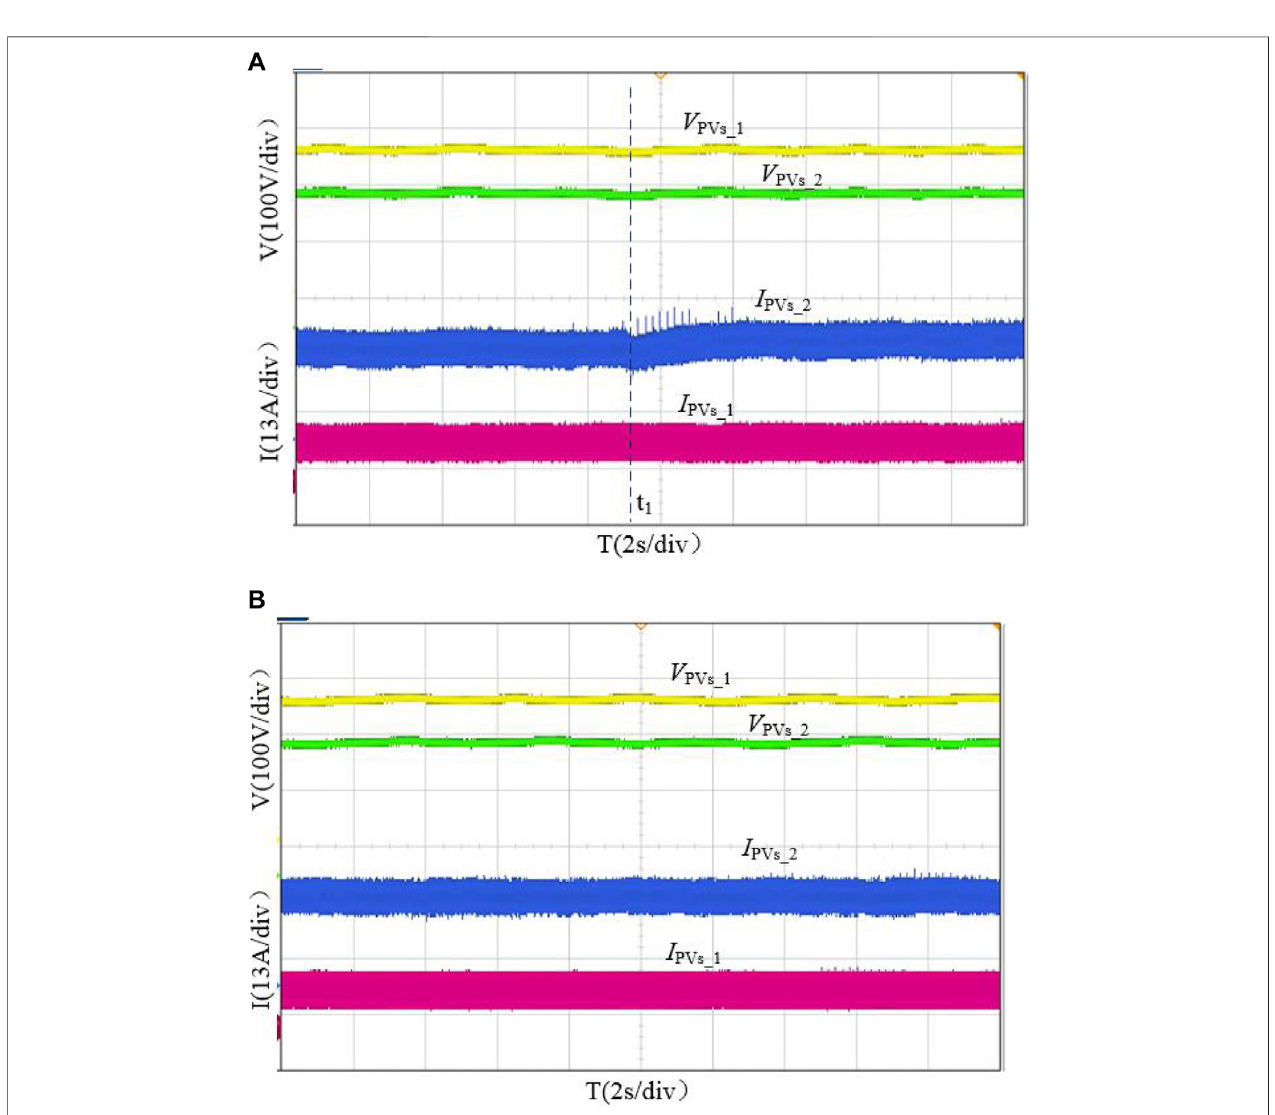
FIGURE 17 | Experimental waveforms of the parallel-connected input mode: (A) at the starting stage and (B) at the normal working stage.